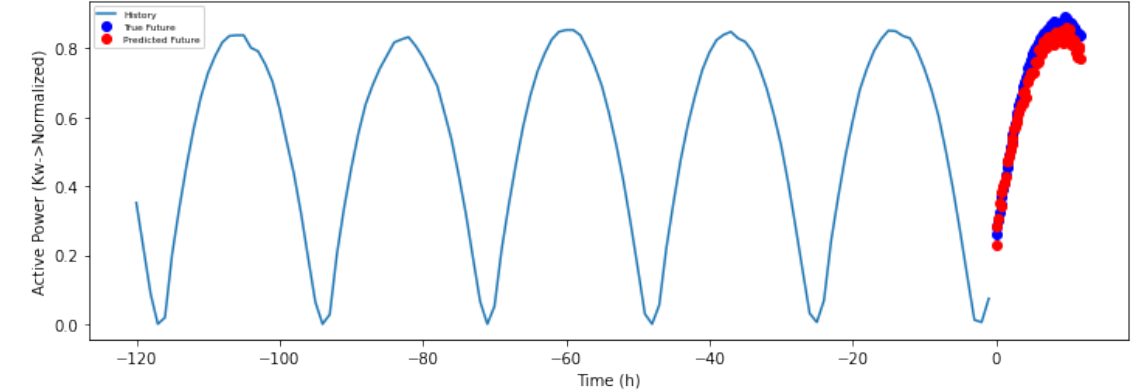
Figure 5. Output power of the solar module in the evaluation